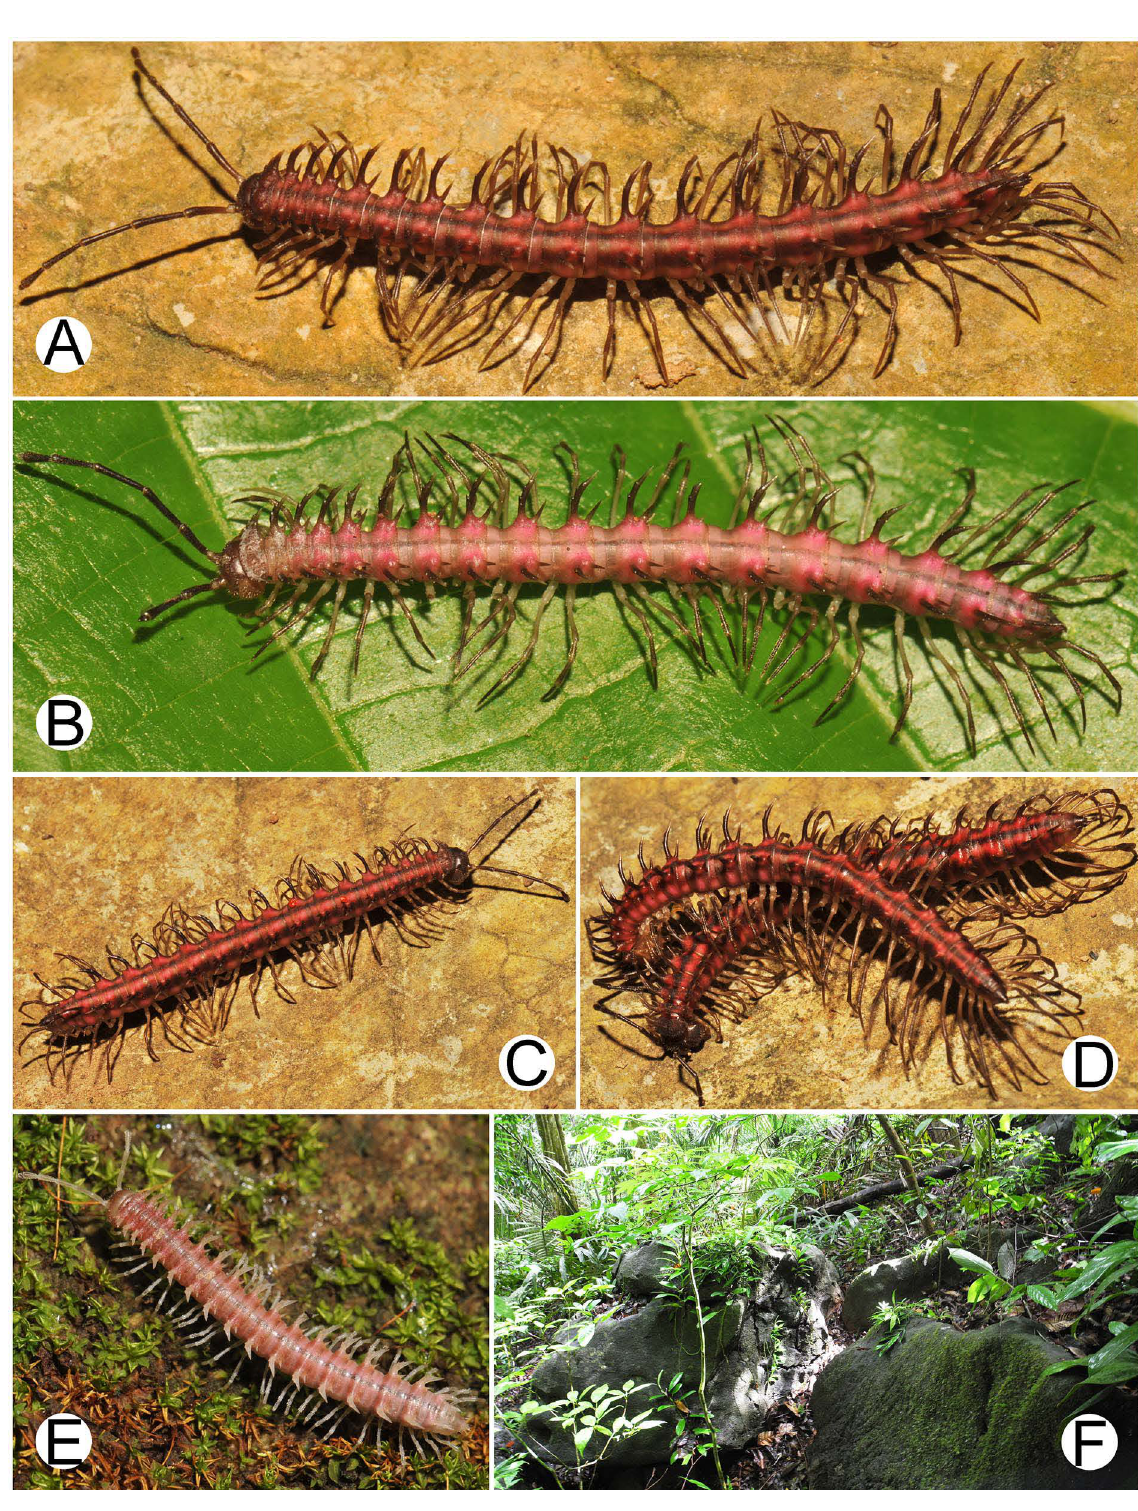
Fig. 19. A – E . Photographs of live Gigaxytes suratensis Srisonchai, Enghoff & Panha gen. et sp. nov . A . ♂ paratype, specimen from Ban Song Phi Nong. B . ♂ , specimen from Wat Satit Khirirom. C . ♀ paratype, specimen from Ban Song Phi Nong. D . Mating couple (paratypes). E . Juvenile. F .